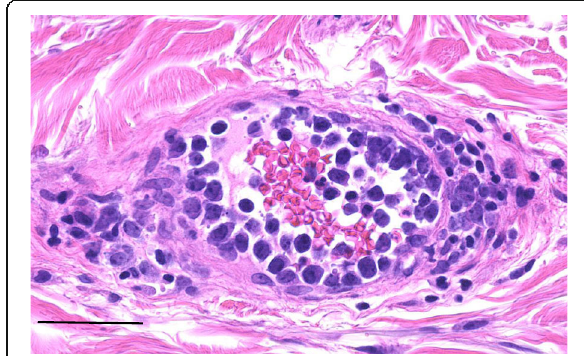
Fig. 2 Histopathological findings of random skin biopsy. Many lymphocyte-like atypical cells were distributed in small blood vessels, and some were distributed in the dermis and subcutaneous adipose tissue (magnification 400×, bar: 50 μ m)